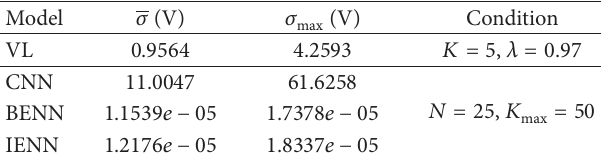
Table 4: Spectrum error of four behavioral models with LFM signal